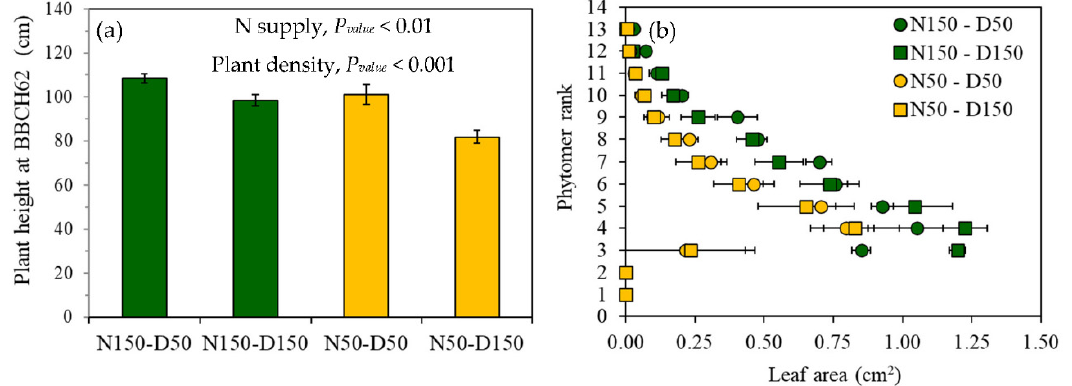
Figure 2. ( a ) Plant height in response to N supply and plant density. Vertical bars indicate the standard error of means. ( b ) Leaf area for each phytomer rank (includes main stem and branch leaf area) at Biologische Bundesanstalt, Bundessortenamt and Chemical industry (BBCH) 62 in response to N supply and plant population density. Horizontal bars indicate the standard error of